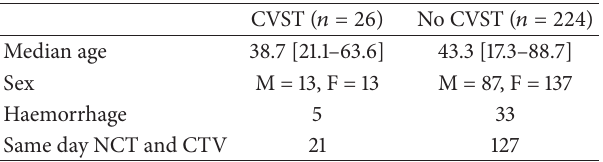
Table 1: Patients’ characteristics.